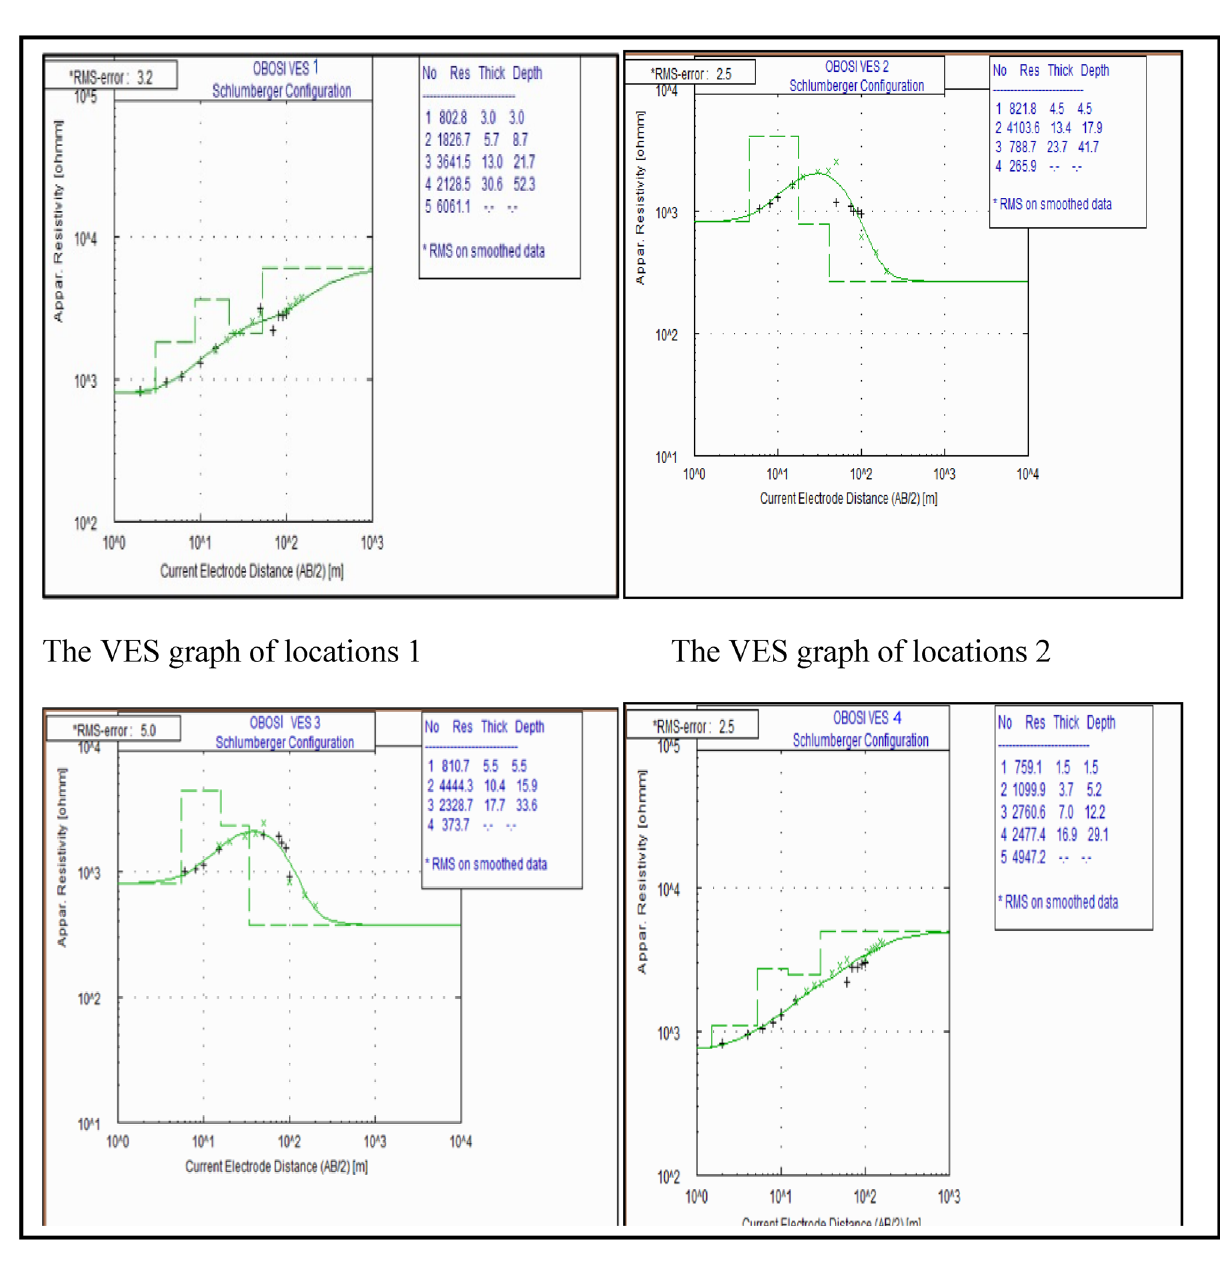
Figure 9. Vertical electrical sounding of locations 1, 2, 3, and